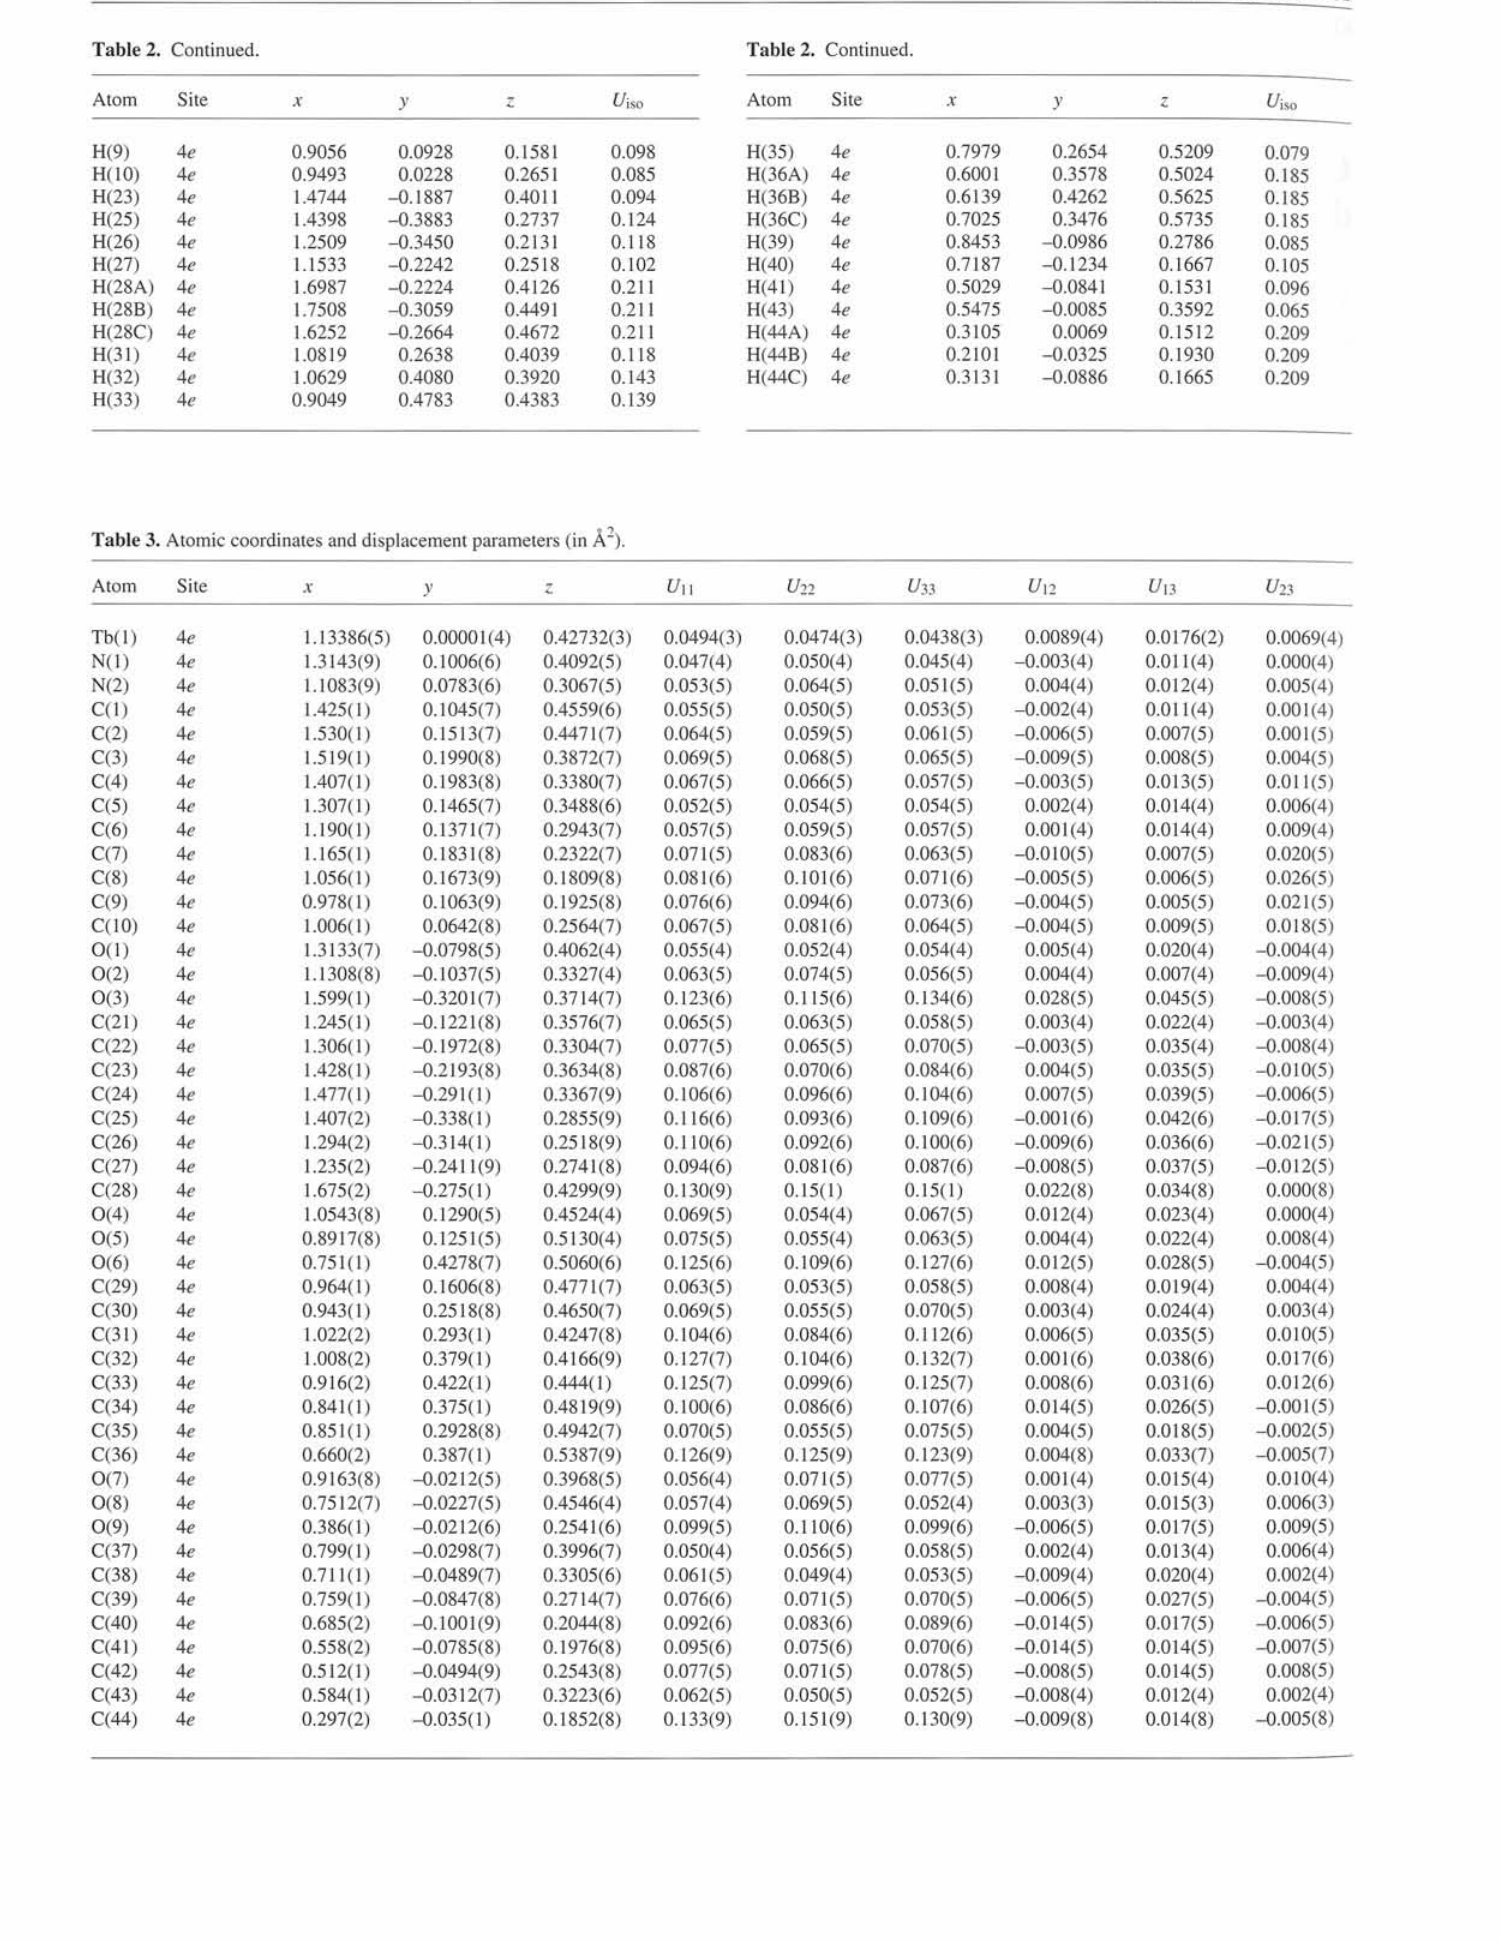
Table 3. Atomic coordinates and displacement parameters (in